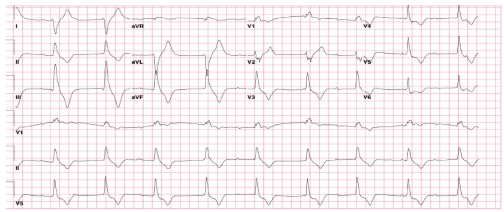
Figure 1: Electrocardiogram demonstrates complete heart block with a wide ventricular escape rhythm at 55 beats per minute.